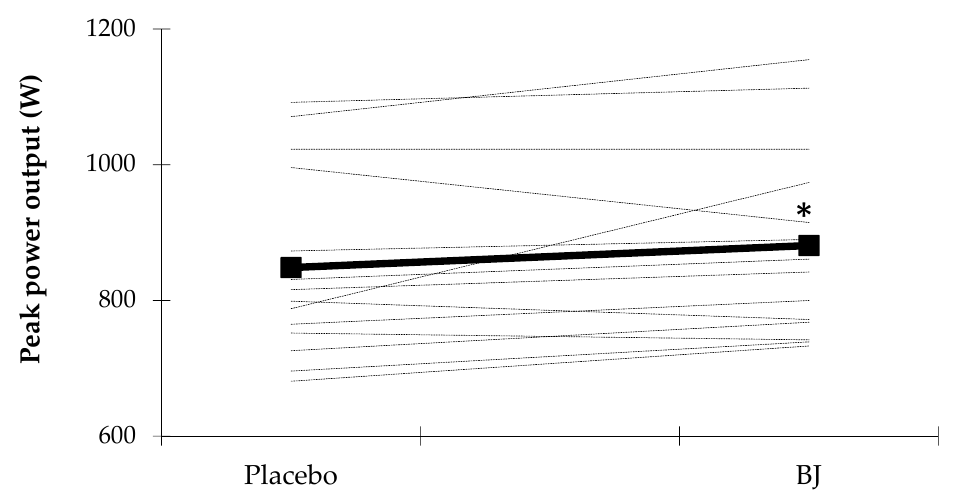
Figure 2. Effects of placebo and BJ intake on W peak after sprint exercise. Means and individual values are shown as a bold or dotted line respectively. * p < 0.05 compared to placebo. BJ, beetroot juice. Values of W mean were recorded in 10 and 15 s intervals. Figure 3 displays W mean values in 15 s intervals (W 0–15s and W 15–30s ). An increased W mean was observed after BJ intake compared to placebo during the first 15 s of the sprint (placebo vs. BJ, 709 ± 113 vs. 740 ± 122 W 0–15s ; p = 0.017), while no significant differences were recorded during the last 15 s (placebo vs. BJ, 574 ± 80 vs. 593 ± 87 W 15–30s ; p = 0.173).